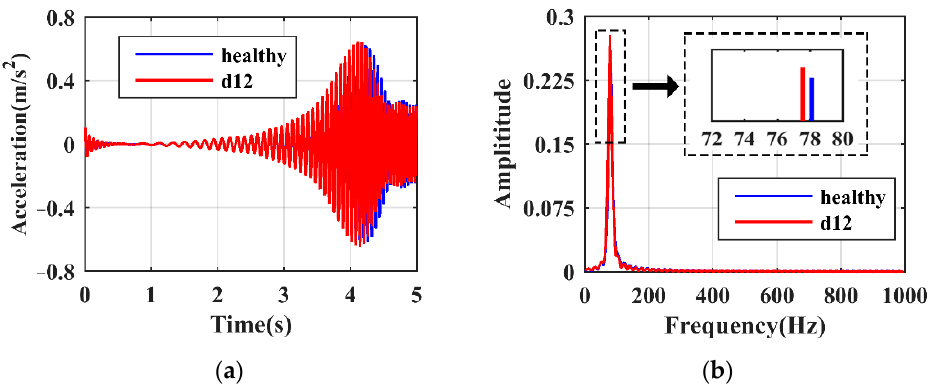
Figure 7. Damage characteristics of case ‘d1t’: ( a ) time domain; ( b ) frequency domain.